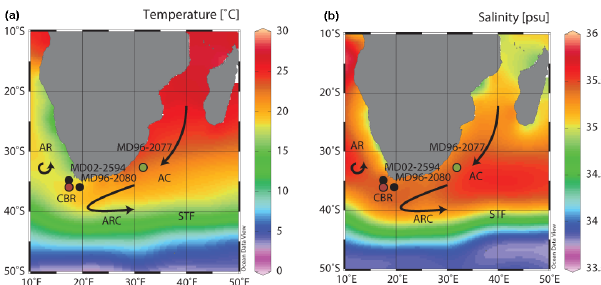
Fig. 1. Location of the cores MD02-2594 and MD96-2080 (black dots) and reference site Cape Basin record (CBR, red dot) (Peeters et al., 2004), MD96-2077 (green dot) (Bard and Rickaby, 2009) and oceanographic setting on (a) a map of modern sea surface temper- atures and (b) a map of modern sea surface salinity. Agulhas Cur- rent (AC), Agulhas return current (ARC), Agulhas rings (AR) and subtropical front (STF). The underlying maps of modern sea sur- face temperatures and salinity were compiled with high-resolution CTD data from http://www.nodc.noaa.gov and the Ocean Data View software version 4.3.7 by Schlitzer, R., Ocean Data View (http://odv.awi.de),